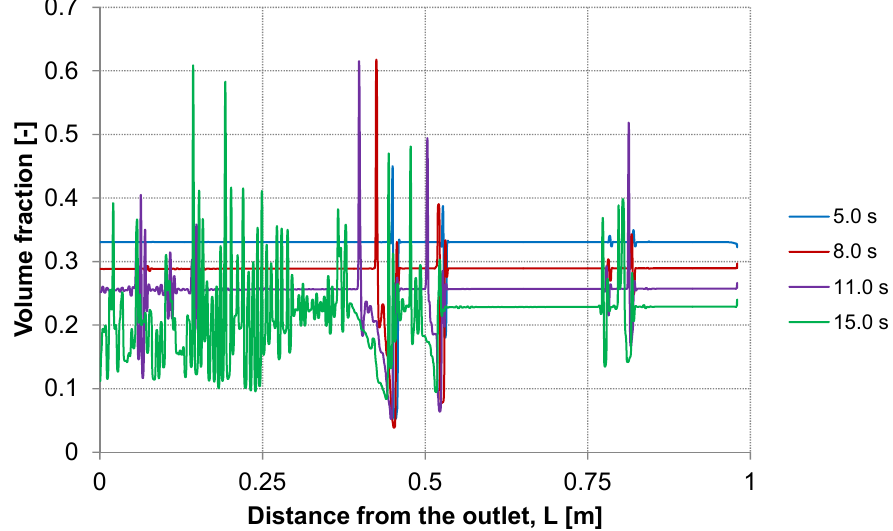
Figure 17. Particle distribution at control line D with backwashing flux of 100 L m − 2 h − 1 , (deposited layer as initial